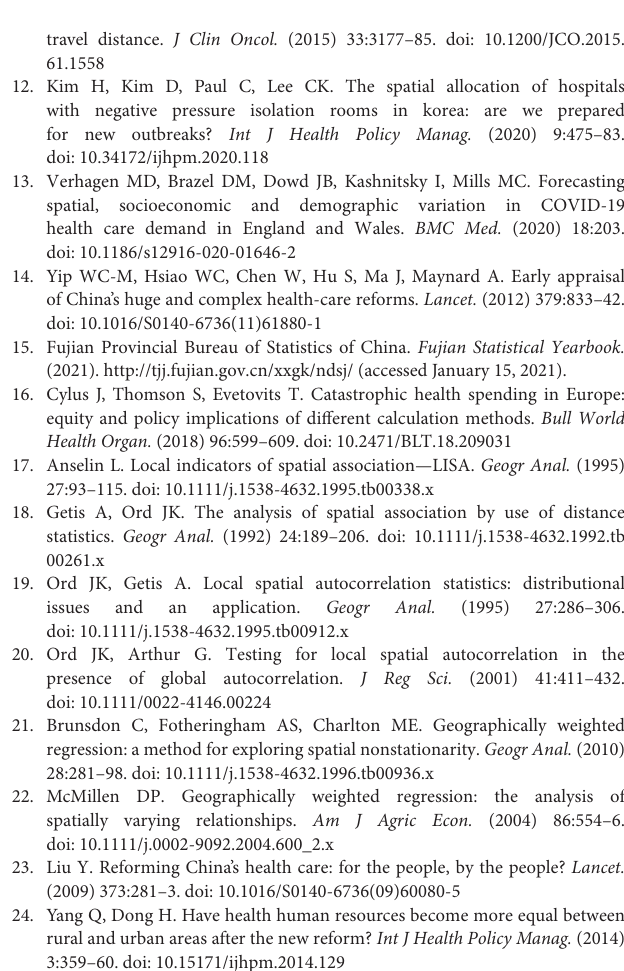
Supplementary Figure 1 | Spatial distribution of the standard deviation of the OLS model. Supplementary Figure 2 | Spatial distribution of the coefficient of explanatory variables. Supplementary Table 1 | Definition and measurements of